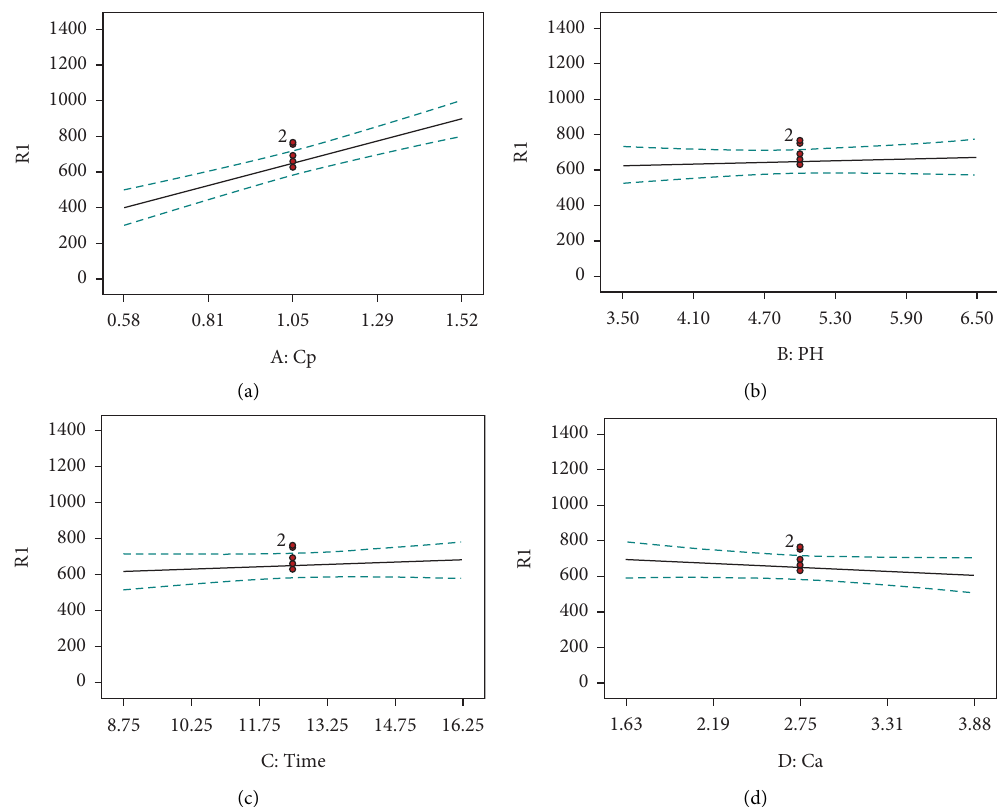
Figure 8: (a) Efects of initial concentration Pb (II), (b) pH, (c) nano adsorbent dosage, and (d) contact time on Pb (II) removal